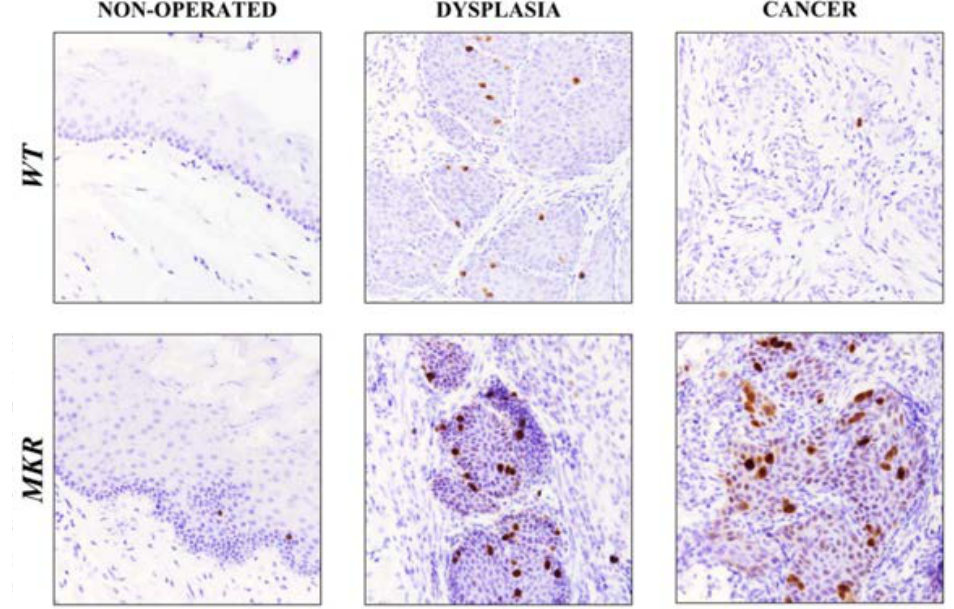
Figure 6. Representative case of Ki-67 nuclear protein expression on healthy, dysplastic and neoplastic esophageal tissues in WT and MKR mice. Non-operated mice (healthy tissue): WT male and MKR male at 43 weeks of age. Dysplasia: squamous high-grade dysplastic lesions (HGD) in WT female and MKR female. Cancer: Moderately well differentiated ESCC in WT male and MKR male. Original magnification 40 ×